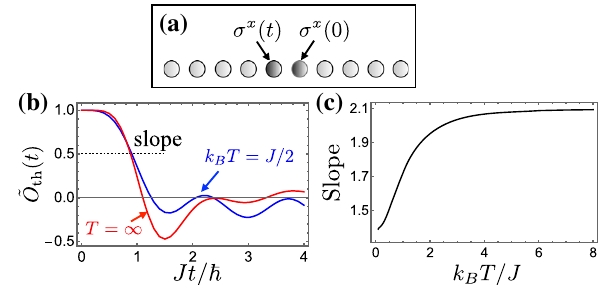
Fig. 6 Thermal OTOC in a many-body model given by Eq. (37) for a system of size N = 10 qubits. a The W and V are chosen to be Pauli operators at adjacent sites. b The decay of the normalized OTOC ˜ O ( t ) = O ( t )/ O ( 0 ) , is shown for different temperatures T . c The th th th temperature dependence can be studied by inferring the slope when ˜ O ( t ) = 0 . 5. We see that the rate of decay increases with th